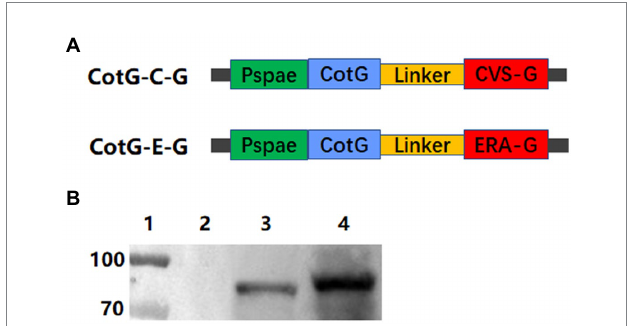
FIGURE 1 Construction and identification of recombinant B. subtilis expressing the immunogenic protein of RABV. (A) Schematic diagram of the construction of plasmids PDG1661-CotG-E-G and PDG1661-CotG- C-G expressing CotG-E-G fusion gene and CotG-C-G fusion gene, respectively. The Pspae represents promoter and the CotG represents spore capsid protein. (B) The expression of the G fusion protein in recombinant B. subtilis was detected by Western blotting. lane1: Maker; lane 2: B. subtilis BS168; lane 3: B. subtilis CotG-C-G; lane 4: B. subtilis